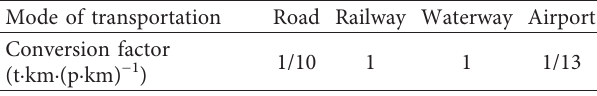
Table 1: Conversion factor of traffic turnover in China.